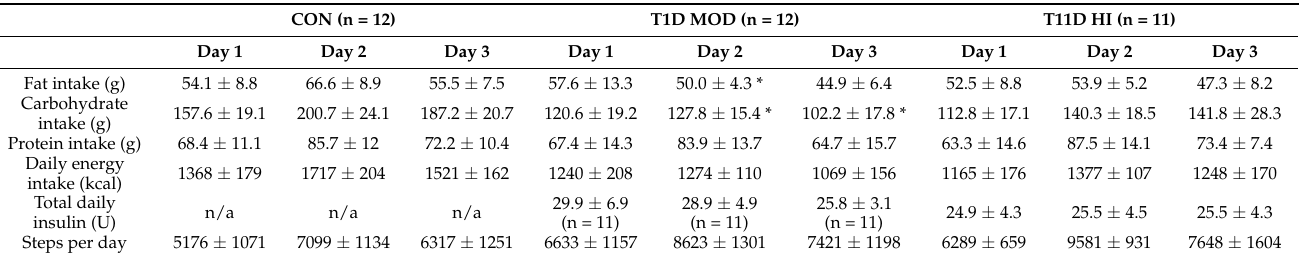
Table 3. Participants’ daily fat, carbohydrate, and protein intakes; daily energy intake; total daily insulin; and steps per day presented as mean ±